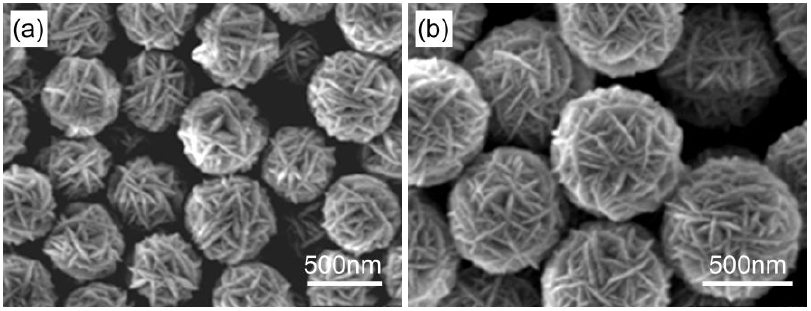
Figure 2. SEM images of the walnut-like CdS nanoarchitectures synthesized via a solvothermal route. Reprinted with permission from [46]. Copyright (2008) Elsevier B.V.